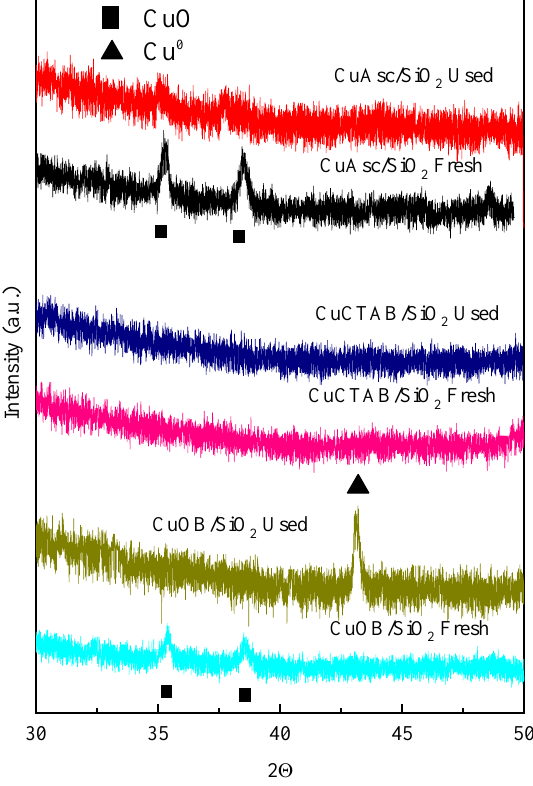
Figure 4. X-ray di ff ractograms of fresh and used Figure 4. X ray diffractograms of fresh and used catalysts.